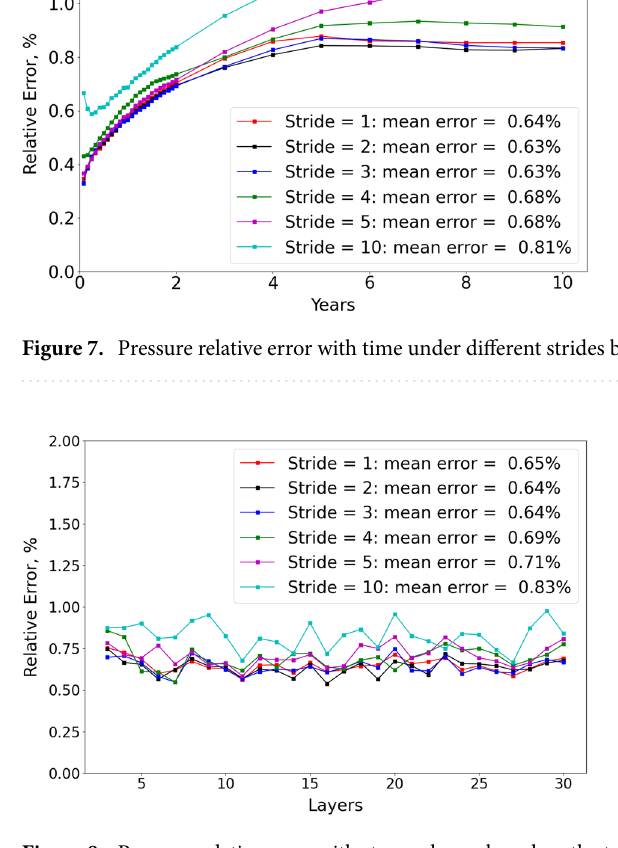
Figure 8. Pressure relative error with storage layers based on the testing